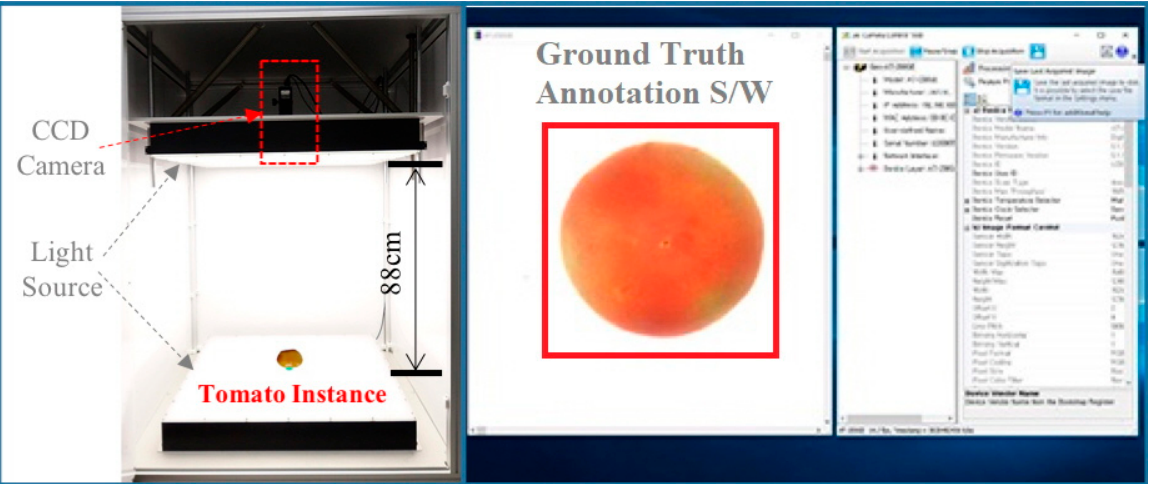
Figure 1. Camera system for acquisition of a large-scale image dataset of “Dafnis” variety tomatoes.